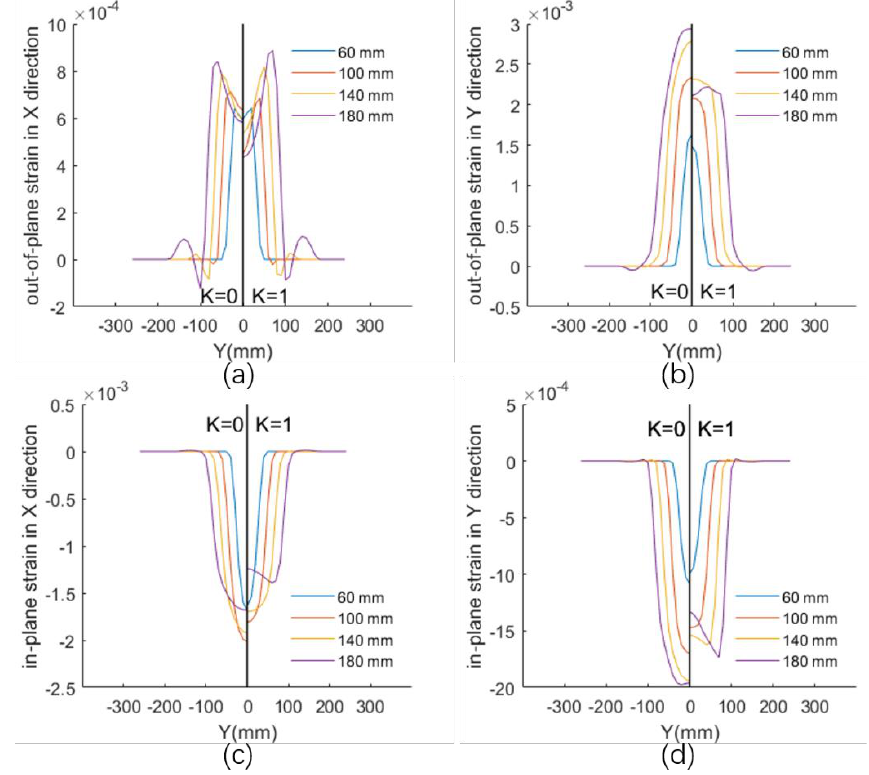
Figure 15. Plastic strain distribution with different coil width in section S B –S B : ( a ) out-of-plane strain in the X direction; ( b ) out-of-plane strain in the Y direction; ( c ) in-plane strain in the X direction; and ( d ) in-plane strain in the Y direction. Table 5. Maximum relative variation.